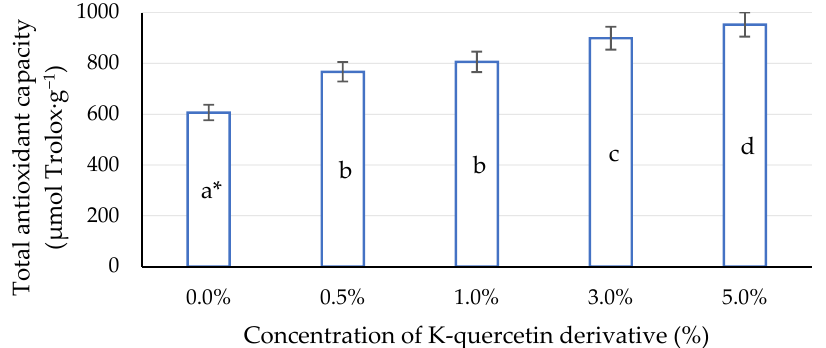
Figure 6. Impact of different aqueous concentrations of potassium quercetin derivative on total antioxidant capacity in maize leaves. * Lower case letters indicate significant differences between concentrations of K-quercetin derivatives ( p < 0.05).